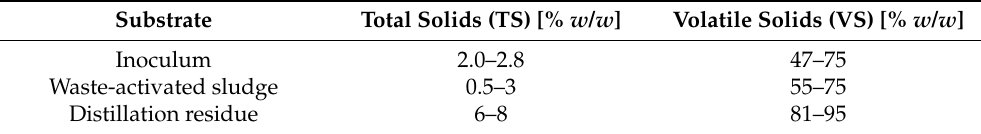
Table 1. Characteristics of the substrates used in the